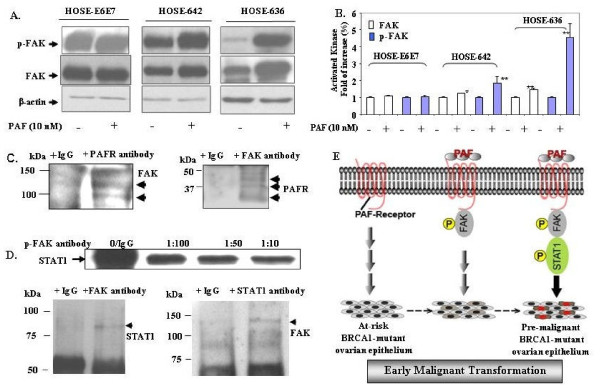
Activation of phosphor-FAK and STAT1 is associated with PAFR in BRCA1 mutant ovarian epithelial cells. (A) The specific phosphorylation of FAK in BRCA1-mutant at-risk HOSE-642 and HOSE-636 cells but not in wild type HOSE-E6E7 cells. (B) Summary of total FAK protein and phosphor-FAK protein induced by PAF treatment in wild type and BRCA1-mutant ovarian epithelial cells. The significant increases (*p < 0.05, **p < 0.01) were compared to the control cells treated with equal volume of DMSO (as 100%). (C) Protein-protein interaction between PAFR and FAK was detected by co-immune precipitation. Antibodies against PAFR and FAK were used for immune precipitation and incubated with protein lysate of HOSE-642 cells with 10 nm PAF treatment, and non-specific IgG was used as negative control. The immune precipitated protein complex was separated on SDS gels and detected by FAK and PAFR antibodies, respectively. (D). Protein-protein interaction between FAK and STAT1 was detected either by immune depletion assay or by co-immune precipitation with phosphor- and non-phospho antibodies of STAT1 and FAK. (E) Simplified scheme to show the integrative signal cascade and activation of PAFR, FAK, and STAT1 as early events of malignant transformation in BRCA1-mutant at-risk ovarian epithelium, particularly under the inflammatory conditions mediated lipid signaling (i.e. PAF).